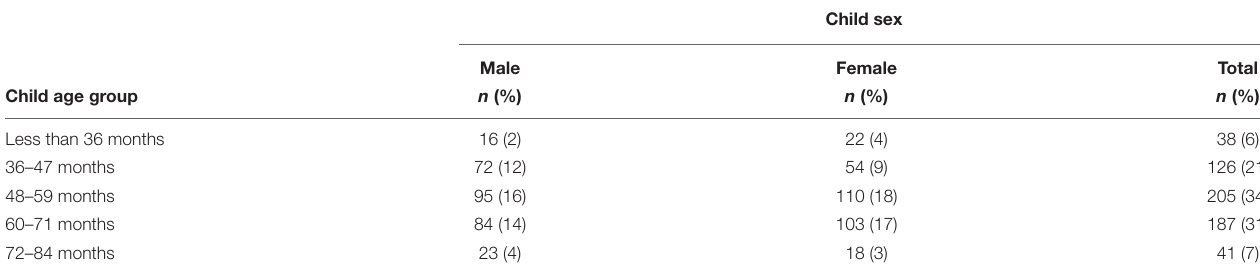
TABLE 2 | Children’s age distribution, according to gender ( N =